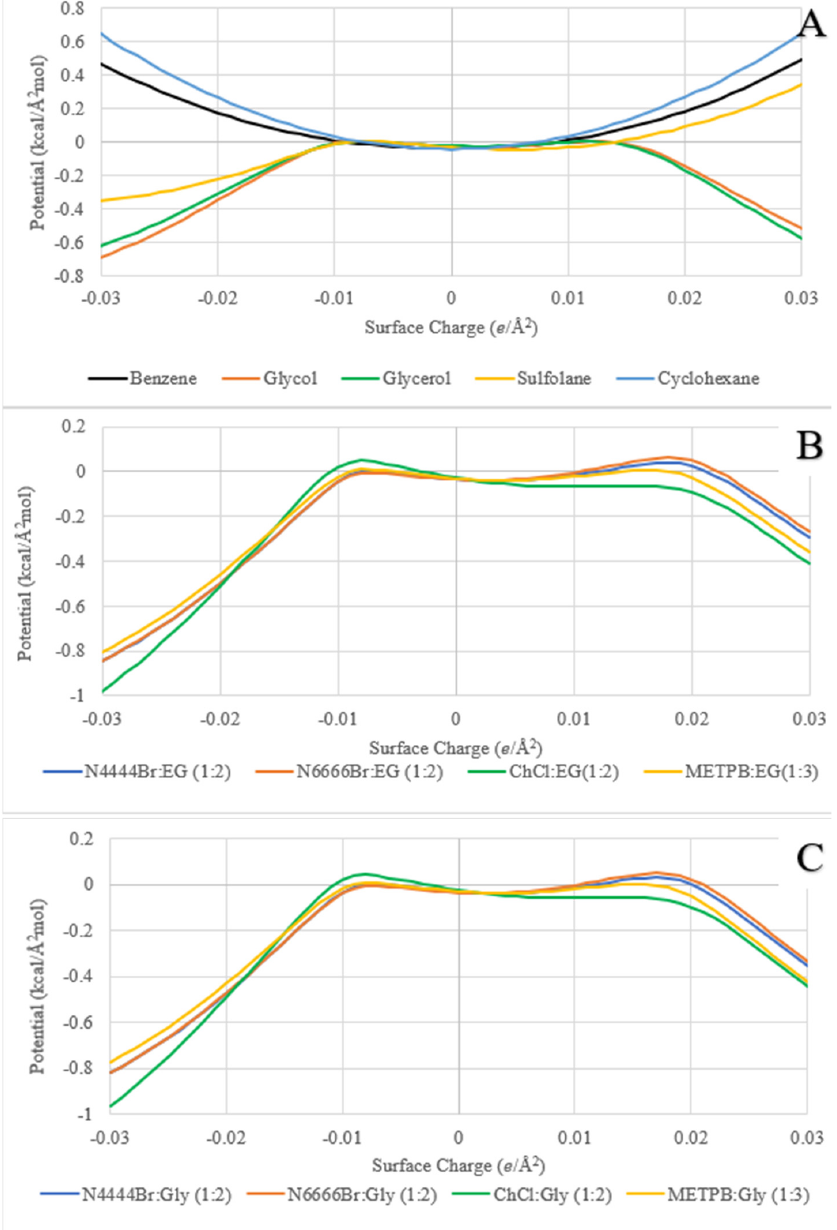
Figure 2. Sigma Potential of ( A ) Pure Solvents and Benzene ( B ) Ethylene Glycol Based DES and ( C ) Glycerol Based DES .